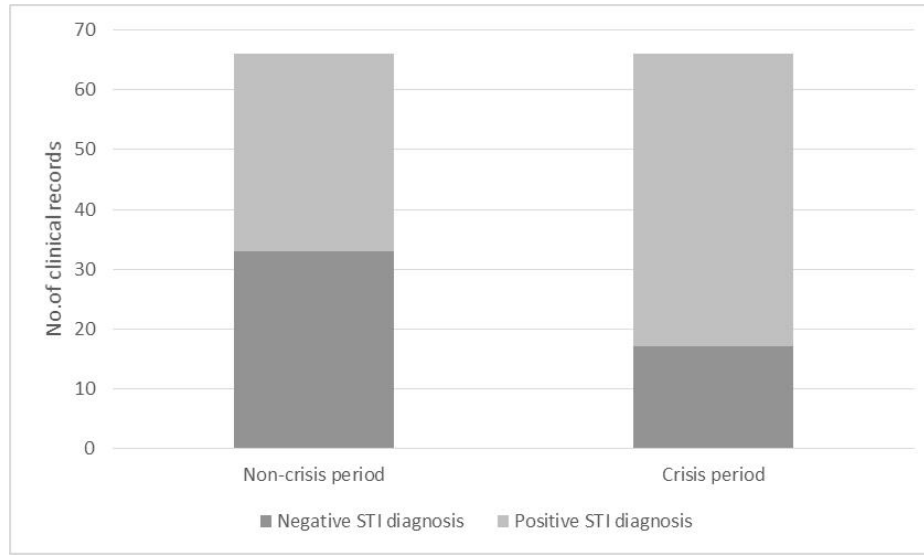
Figure 2. Sexually Transmitted Infections (STIs) diagnosis vs. Crisis / Non-crisis period. Table 5. Logistic regression for STI diagnosis vs.